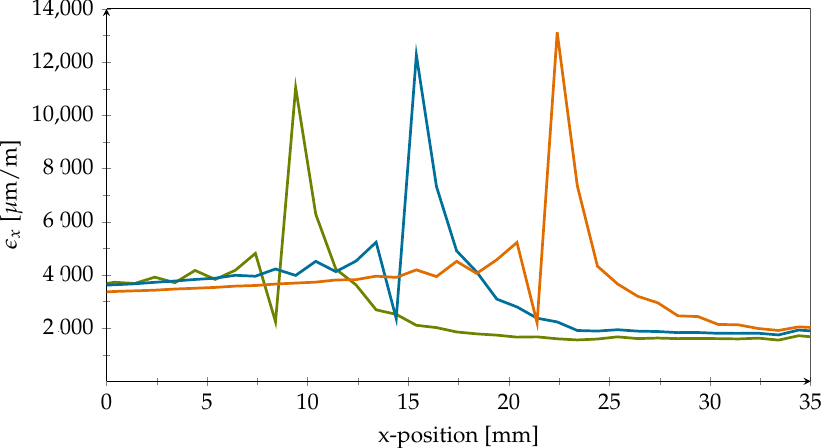
Figure 11. Nominal strain in x-direction in track bridge for different crack lengths. Green: 10 mm, Figure 9. Nominal strain in the x-direction in track bridge for different crack lengths: green, 10 mm; Blue: 16 mm, Orange: 23 mm blue, 16 mm; orange, 23